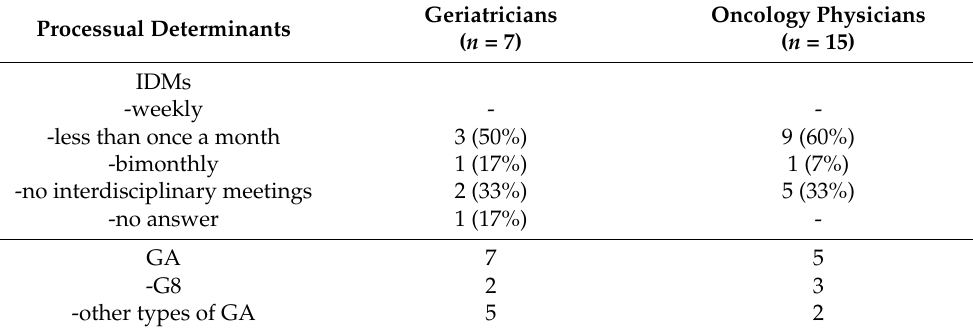
Table 3. Processual determinants for oncogeriatric medical